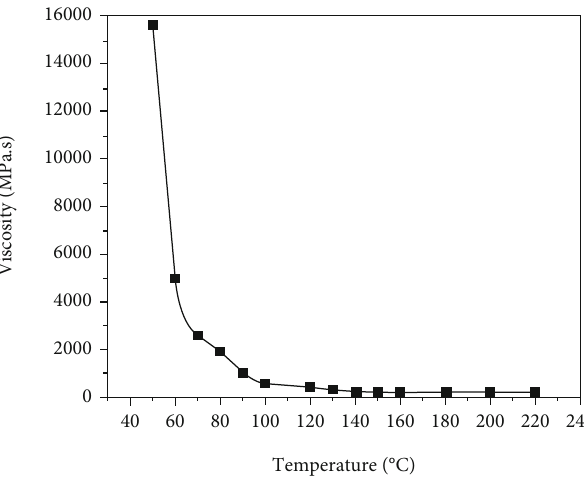
Figure 4: Viscosity-temperature relationship of oil used in this